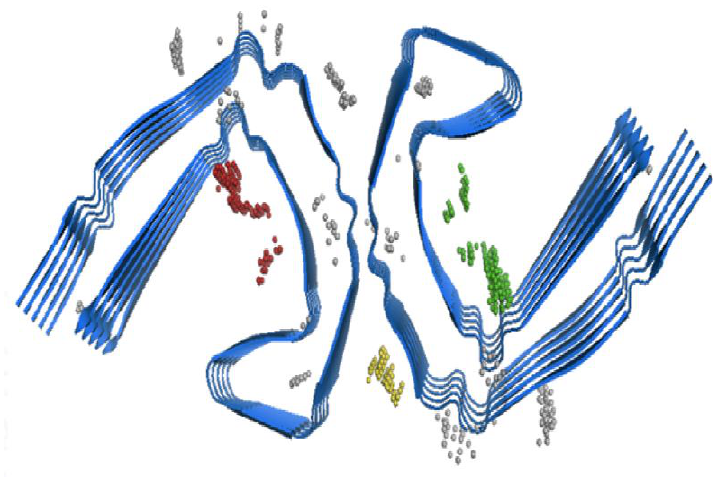
Figure 2. Results from ClusPro modeling showing the interaction between PHF tau and LRP1 Clus- ter 2 (CCR2) domain. The 23-amino-acid segment SKAWVCDGDNDCEDNSDEENCES is shown in green. The LRP1 binding pocket identified from this model is outlined in pink. ( a ) Shows the inter- actions with the entire CCR2 domain with PHF Tau. ( b ) Close-up image showing residues of the binding pocket (in pink).